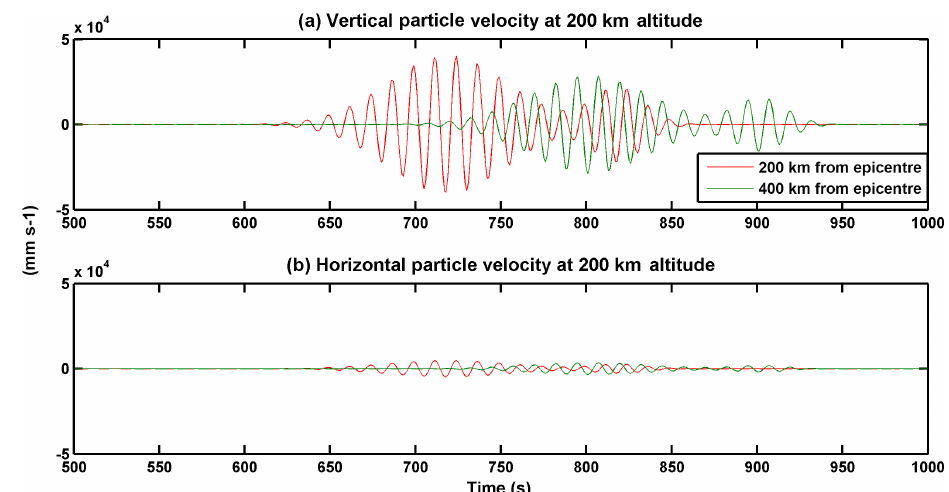
Figure 7. Vertical (a) and horizontal (b) components of the particle velocity associated with the infrasound at 200km altitude. Green and red colours indicate different epicentral distances. Note that the vertical component is significant in comparison to the horizontal.